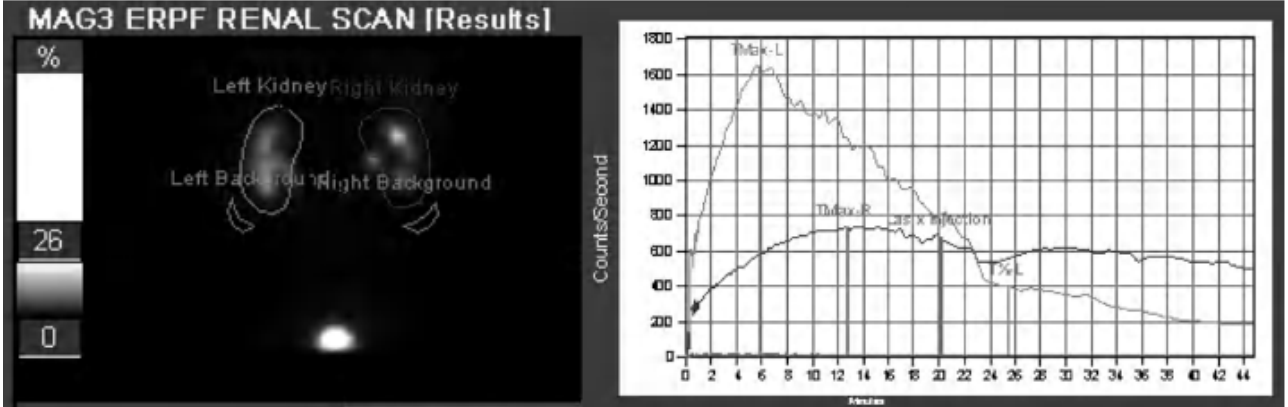
Figure 3. MAG-3 renogram and time activity curve of the patient with obstructing ureteral calculi depicted in Figure 2B. Note the marked asymmetrically decreased right renal counts and decreased and prolonged clearance, confirming the presence of obstructive uropathy and indicating significant functional impairment.